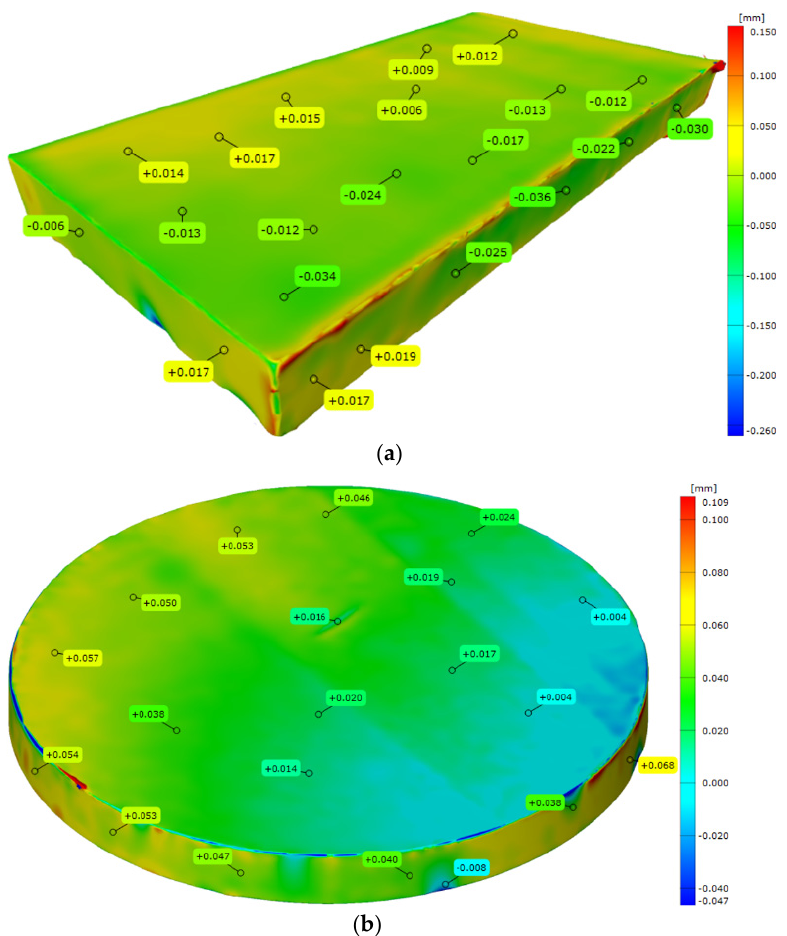
Figure 3. Deviation maps for scans superimposed on nominal CAD models: ( a ) DMLS sample; ( b ) as-cast sample.